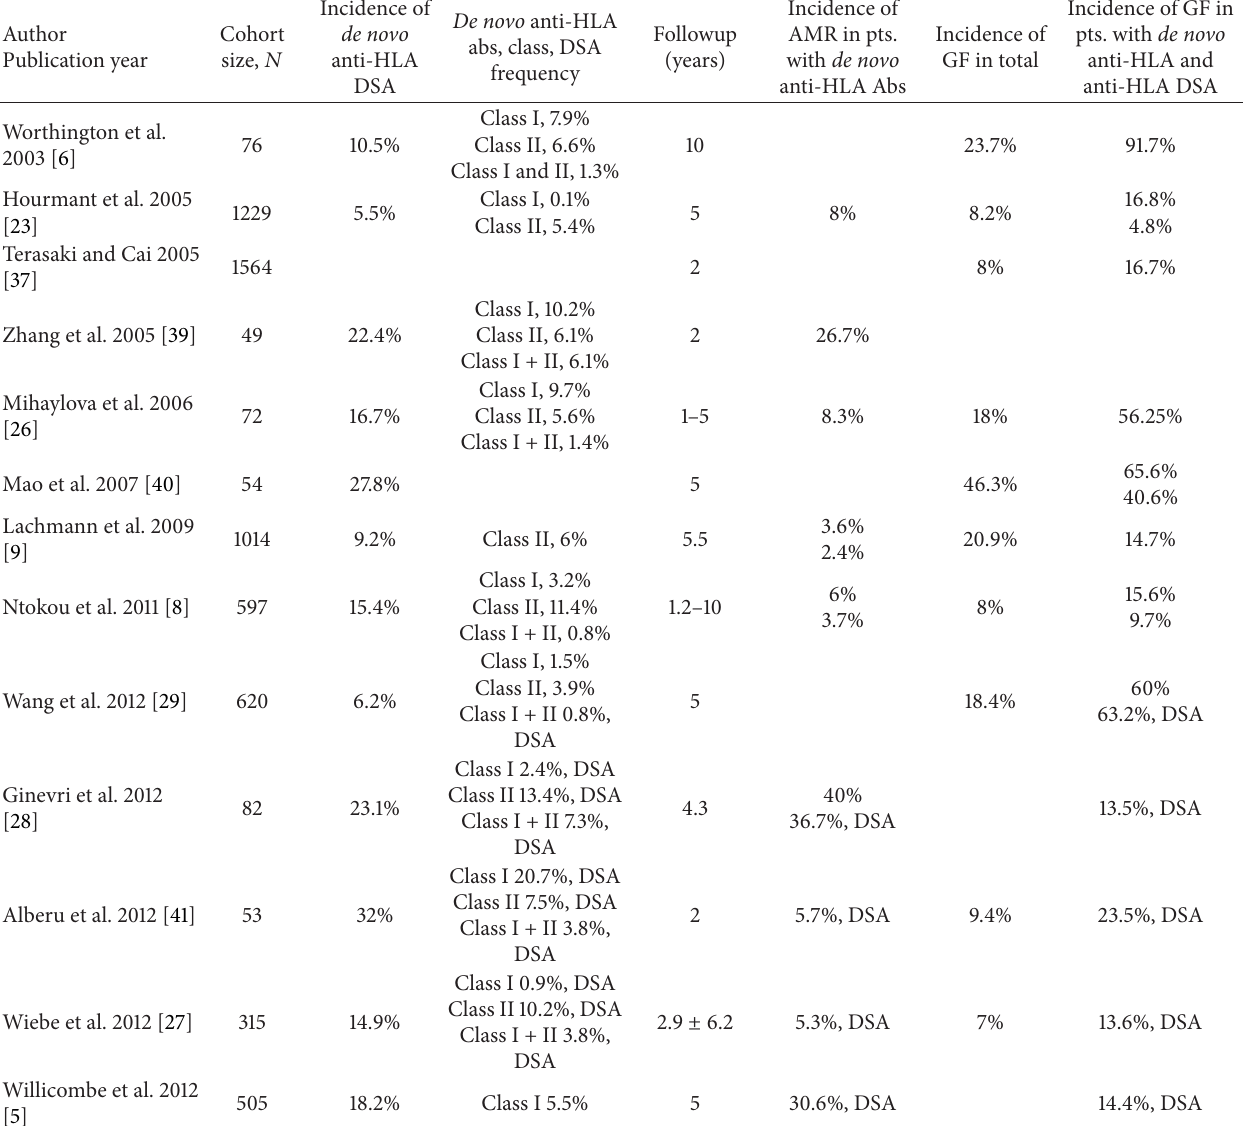
Table 1: Studies searching the incidence of de novo anti-HLA DSA and their impact on graft